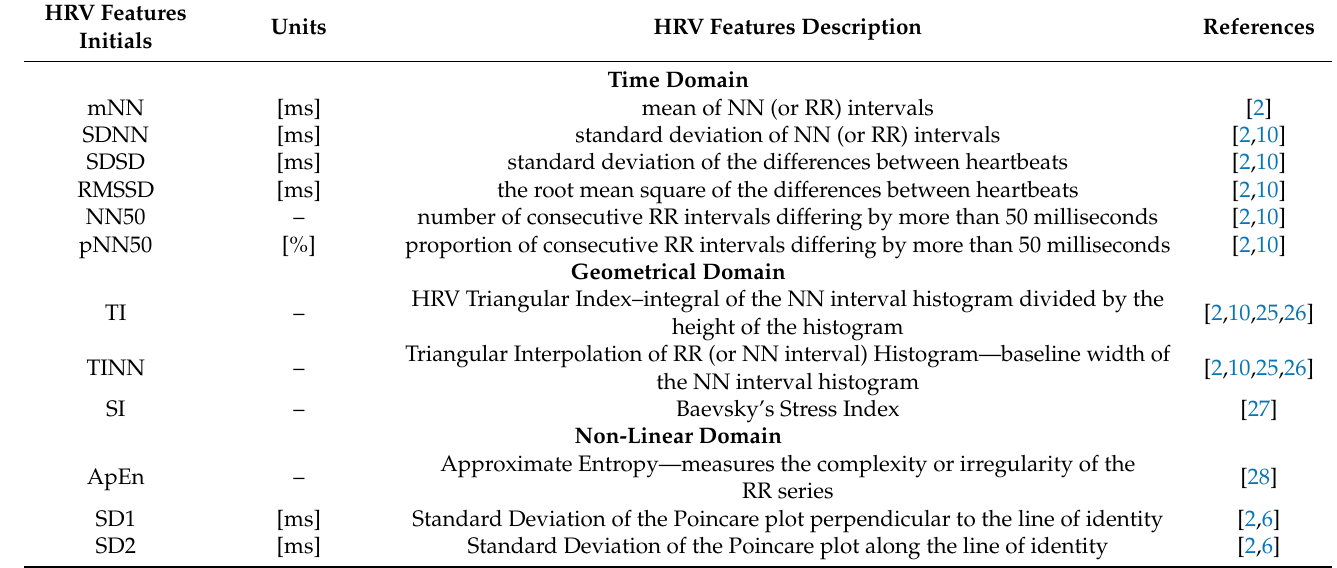
Table 1. Set of Features used in the current study presenting the designation used across the document, the units of measurement, a description of the feature and the papers reporting that feature for the analysis of HRV.